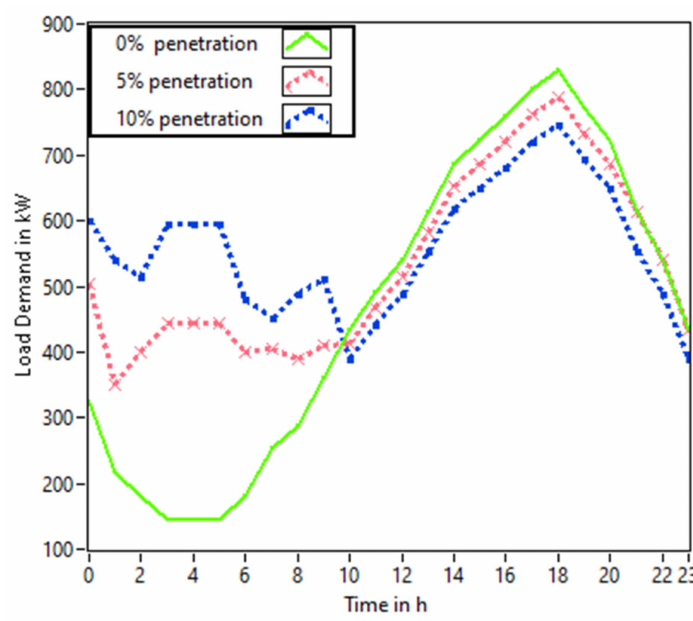
Figure 18. Load demand for three cases